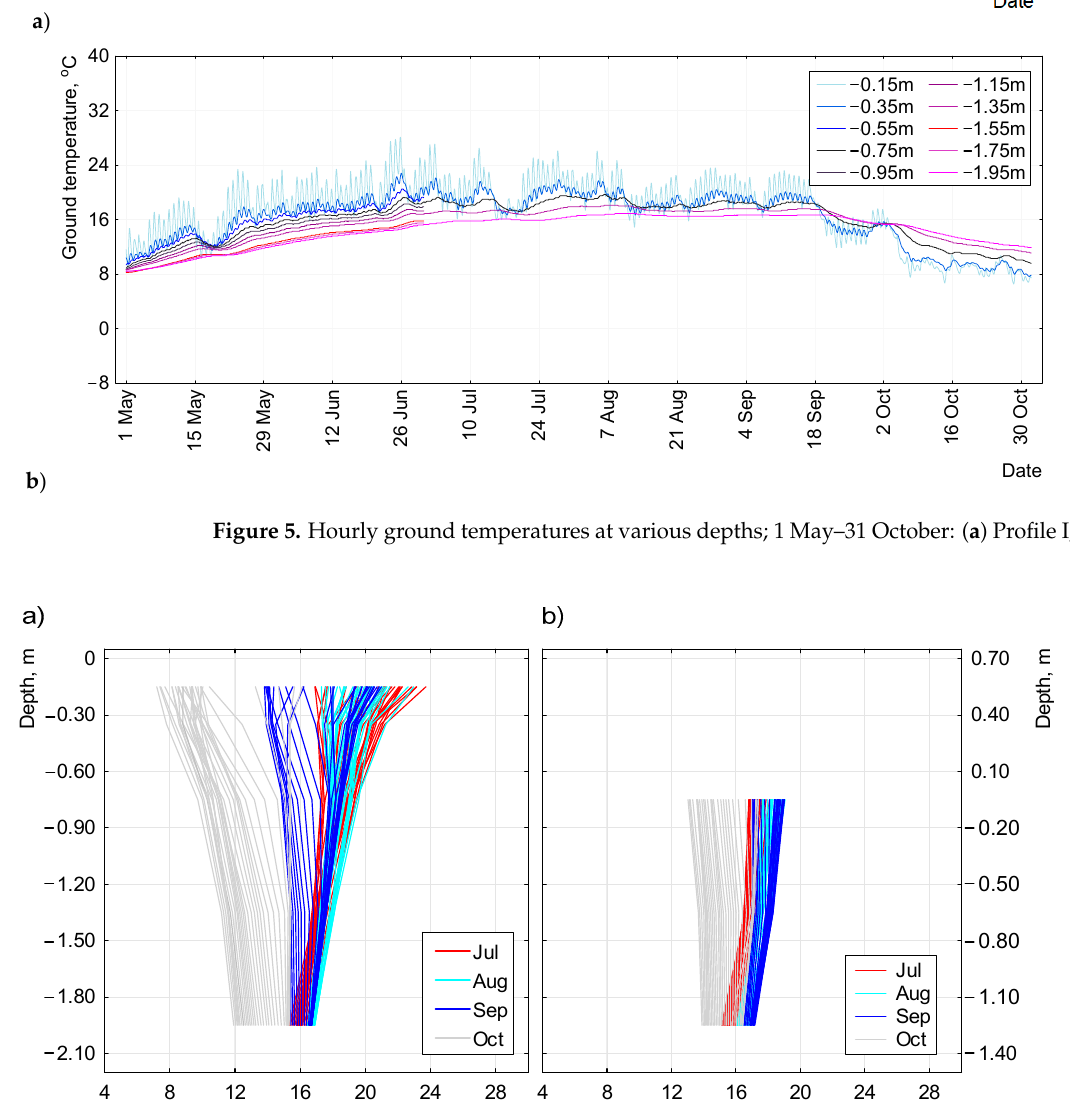
Figure 6. Daily average ground temperature profiles at various depths, 1 July–31 October: ( a ) Profile II; ( b ) Profile